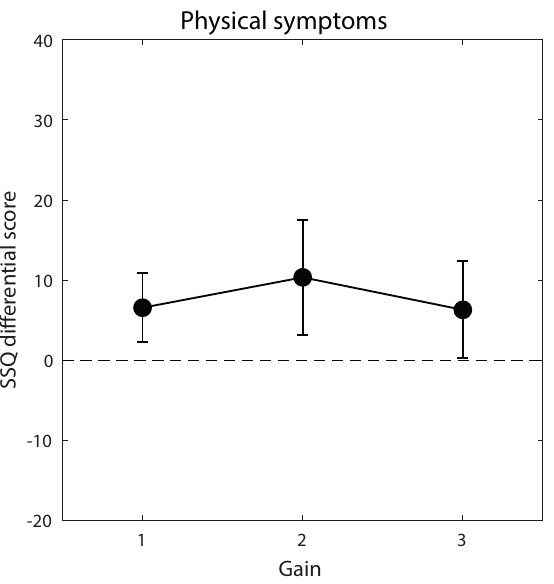
Figure 5. Physical cyber-sickness symptoms as assessed through the SSQ differential score (post-session— pre-session) across the three gain levels. The dashed line indicates a lack of symptoms resulting from the virtual biking session. The maximal score is 235.62. Error bars are 99% confidence intervals of the mean.